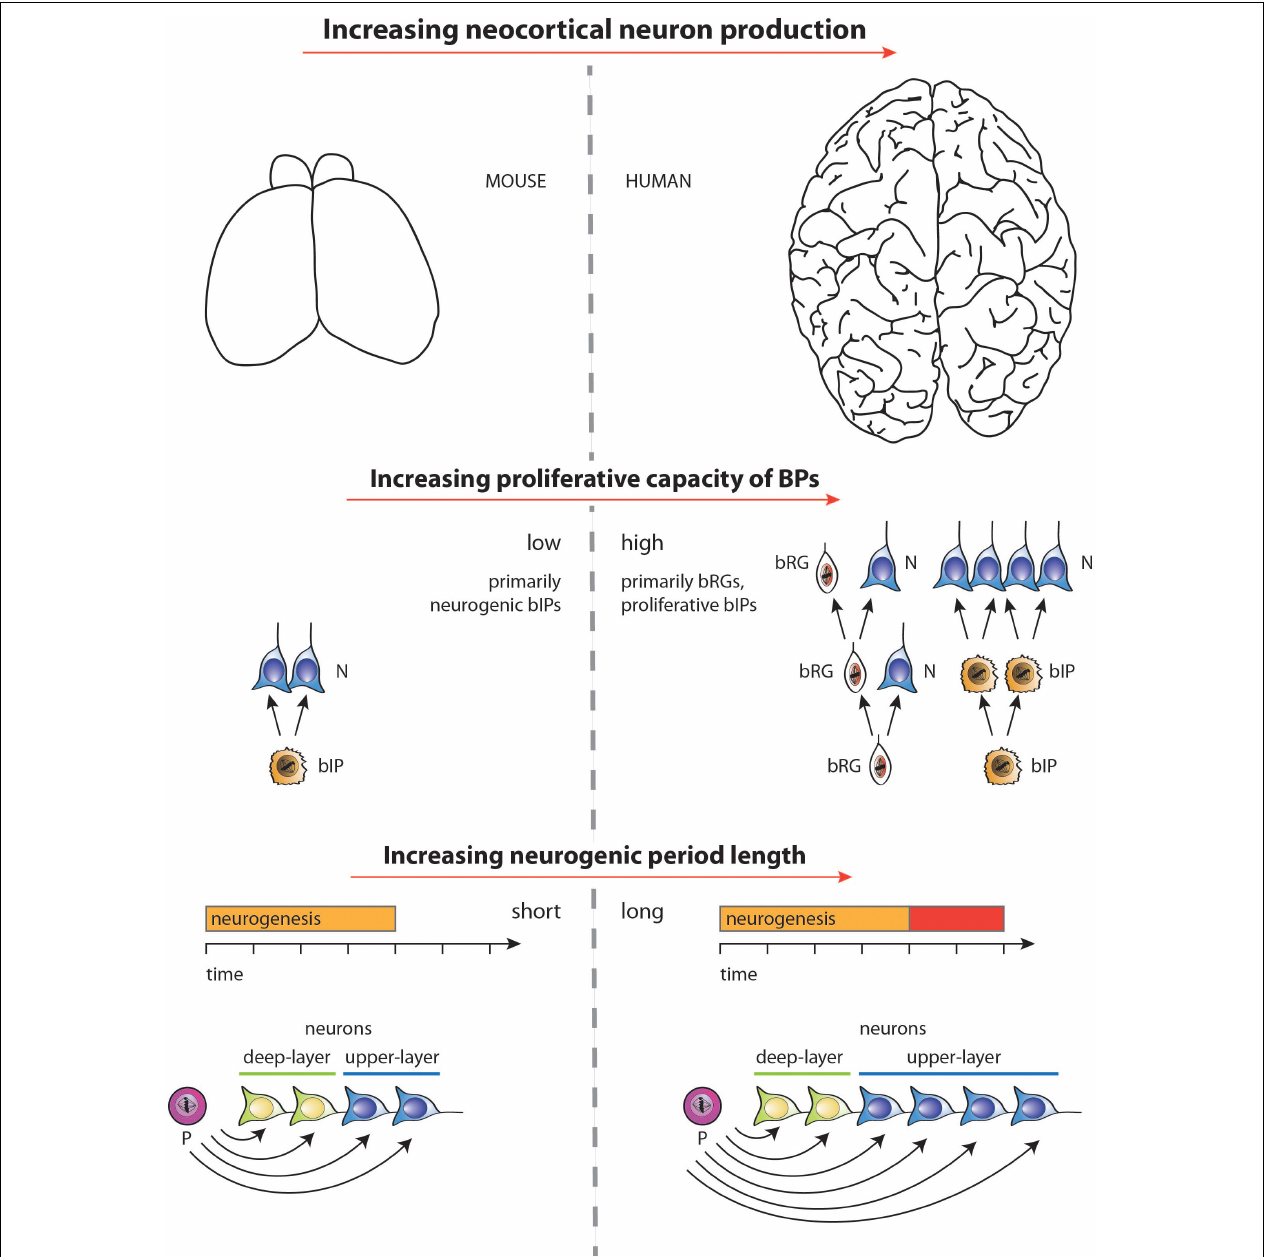
FIGURE 4 | Diagram illustrating the two major factors underlying the increase, during development, in neuron production associated with the evolutionary expansion of the neocortex, as depicted for mouse vs. human in the top row (images not drawn to scale). (1) Middle row: Increase in the proliferative capacity of BPs by changing the type of BPs and their mode of division. BPs in embryonic mouse neocortex comprise mostly bIPs of which each one undergoes a single consumptive division generating two neurons (N). BPs in fetal human neocortex comprise both bRG and bIPs, both of which can undergo various modes of cell division (see Lewitus et al., 2014) of which the following are illustrated. bRG may undergo repeated asymmetric self-renewing divisions generating one neuron each. bIPs may first undergo symmetric proliferative divisions, resulting in an exponential increase in their number, followed by consumptive neurogenic divisions of these bIPs. (2) Bottom row: Selective increase in upper-layer cortical neurons upon lengthening the neurogenic period. Once progenitors (P) that generate neurons (N) have switched from generating deep-layer neurons to generating upper-layer neurons, a lengthening of the neurogenic period (red bar) during neocortex development, e.g., in fetal human as compared to embryonic mouse, will result in selectively increasing upper-layer neurons. For simplicity, and to illustrate the underlying principle, irrespective of the actual lineages in embryonic mouse vs. fetal human neocortex (see middle row), in the example illustrated, a progenitor is assumed to successively generate first deep-layer and then upper-layer neurons by repeated asymmetric self-renewing divisions, which occur for longer in fetal human than embryonic mouse neocortex. Not illustrated—for the ease of presentation—are other lineage scenarios, in which with a mixed population of progenitors, some progenitors undergo symmetric proliferative divisions while others undergo neurogenic, e.g., symmetric consumptive, divisions, with both types of progenitor divisions occurring for longer in species developing an expanded neocortex.